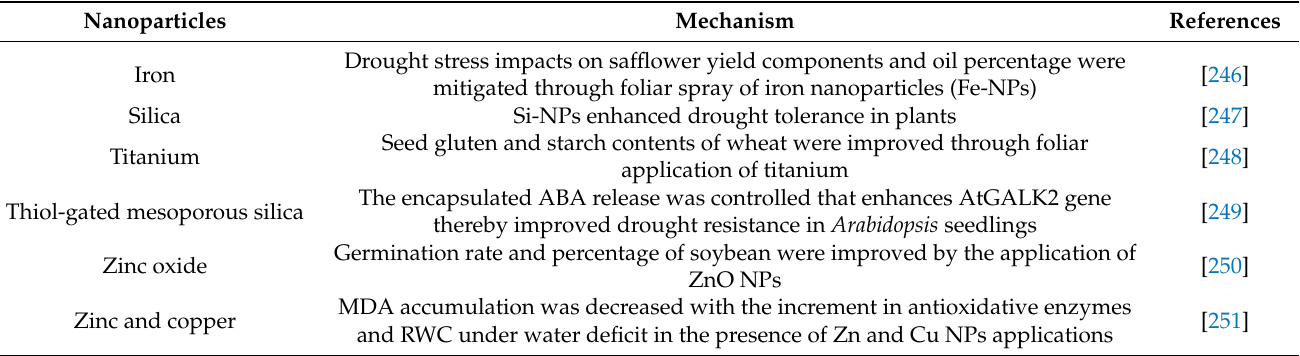
Table 8. Drought stress tolerance enhancement in plants through Nanoparticles